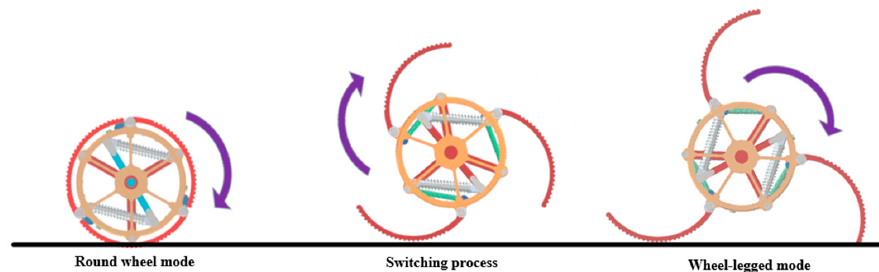
Figure 6. Wheel and wheel-legged mode switch. Without considering the slip, the robot achieves three cycles of 120° phase motion for each week of the rotation of the transformed wheel, as shown in Figure 7. At the beginning of one cycle, trigger leg 1 and trigger leg 3 directly touch the ground. As the motor rotates, trigger leg 1 is gradually lifted and trigger leg 3 begins to make a circular motion at its contact point with the ground. Until trigger leg 3 completes the change from the front leg to the rear leg of the wheel. At this point, trigger leg 3 makes a circular motion along the ground. Trigger leg 2 makes contact with the ground and becomes the front leg of the wheel [22].